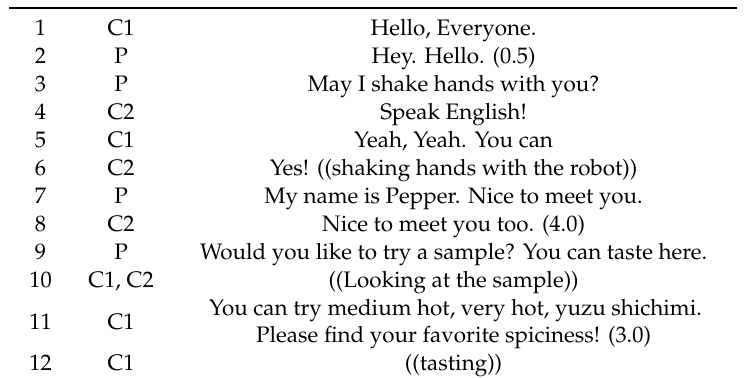
Table 9. Conversation between a group that tasted a sample and the robot with the state-transition model (21 November